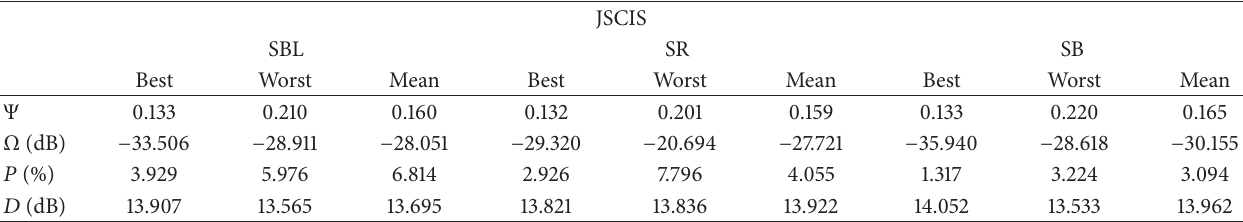
Table 4: Calculated benchmark parameters of DE algorithm outputs for JSCIS.